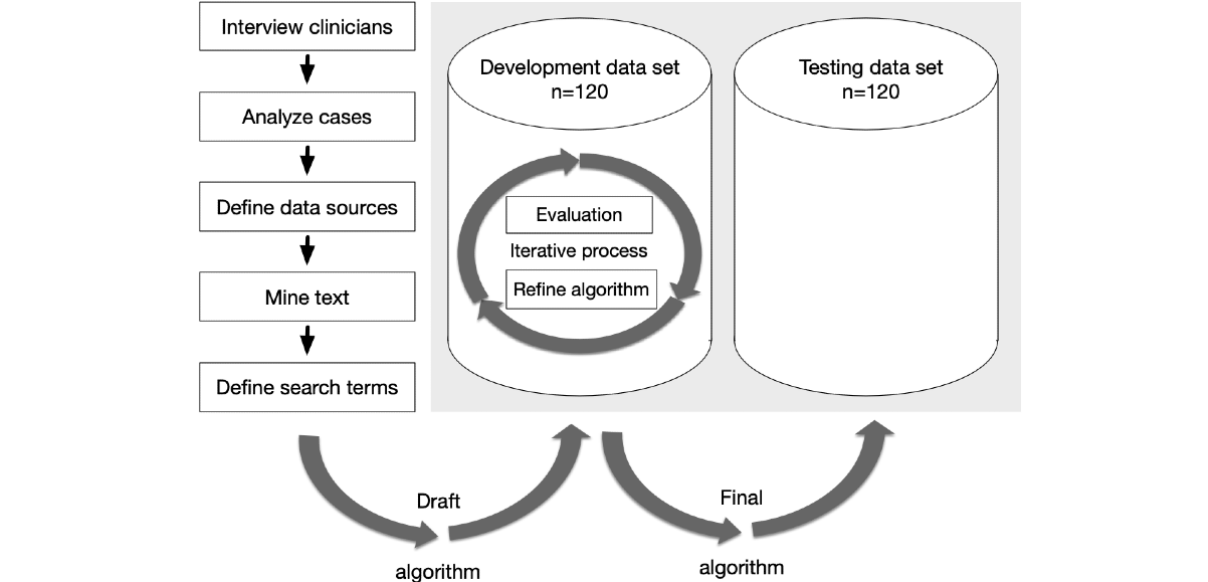
Figure 1. Algorithm development